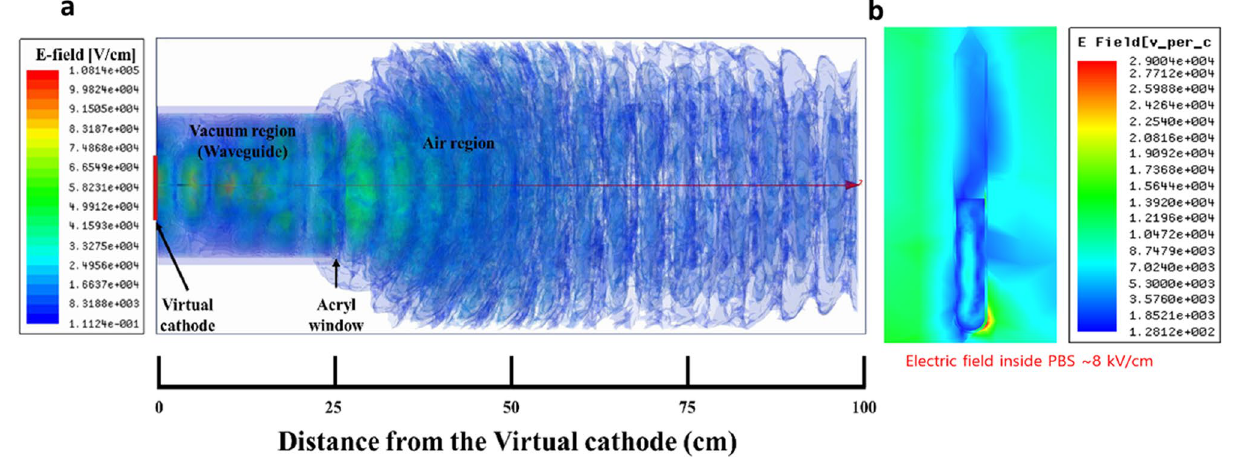
Figure 4. ( a ) Results of the HFSS simulations: electric field distributions in PMR from the virtual cathode to the outside environment (up to 100 cm); ( b ) electric field distribution with 8 kV/cm inside the PBS solution in falcon